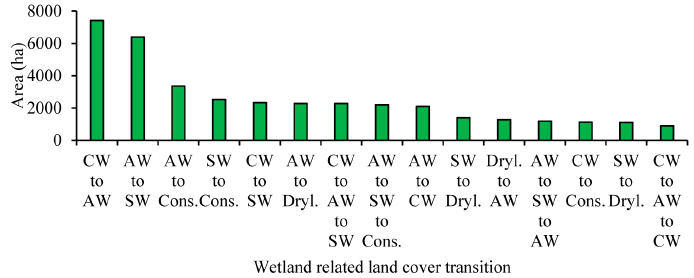
Figure 6. Area of wetland-related land cover change (note: CW, coastal wetland, including sea, mud flat, Scirpus , Spartina ; SW, swamp wetland, including herb; AW, artificial wetland, including water and paddy field; Cons., construction land; Dryl., dryland).